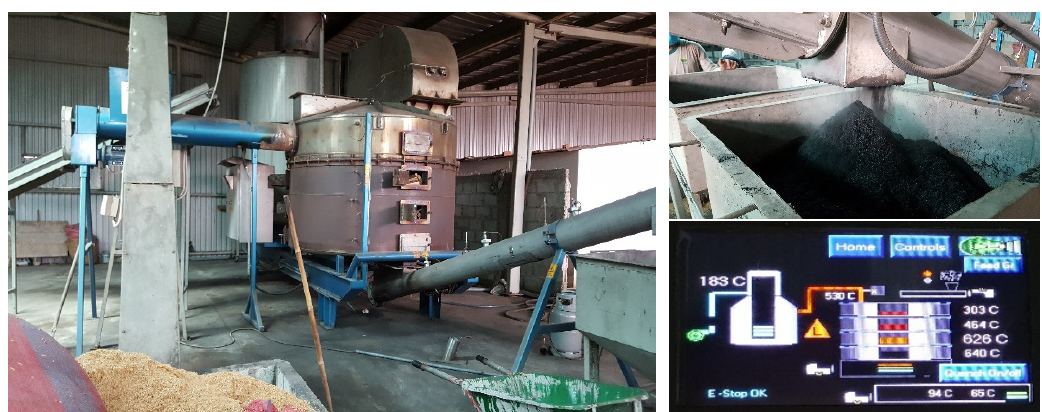
Figure 1. Full-scale gasification system (BiGchar 2200 fast rotary hearth, Pyrocal Pty Ltd, Wellcamp, Figure Queensland, Australia) for biochar production. Owned by Ecofarm Co. Ltd., Long An province, Vietnam.